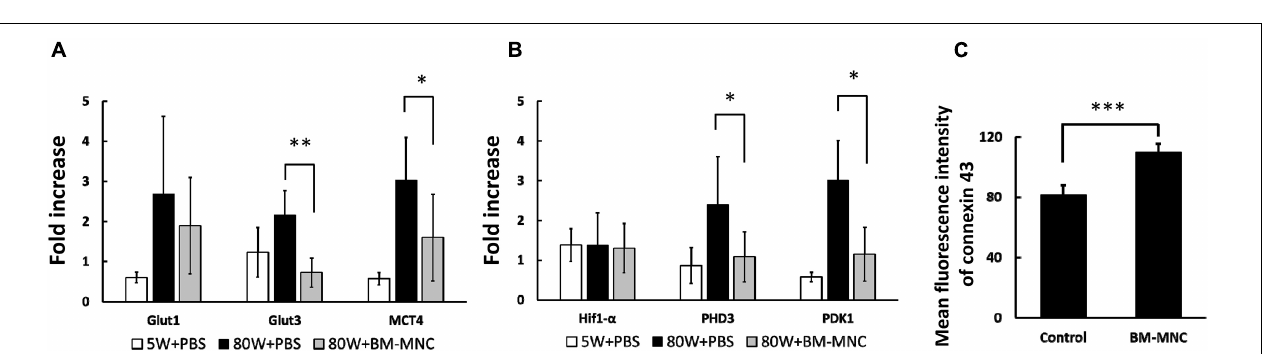
FIGURE 4 | BM-MNC transplantation decreased RNA expression of metabolism related genes in WBC. (A,B) BM-MNC transplantation to aged mice decreased the expression of Glut3, MCT4 (A) , PHD3 and PDK1 (B) in circulating WBC. (C) Co-culture with BM-MNC significantly increased the expression of Cx43 in endothelial cells. ∗ p < 0.05 and ∗∗ p < 0.01 vs. 80W + PBS by ANOVA followed by post hoc analysis using Dunnett’s test (control, 80W + PBS; p values between aged mice were displayed in the figure). N = 5 in each group (A,B) . ∗∗∗ p < 0.001 by Student’s t -test. N = 6 in each group (C)